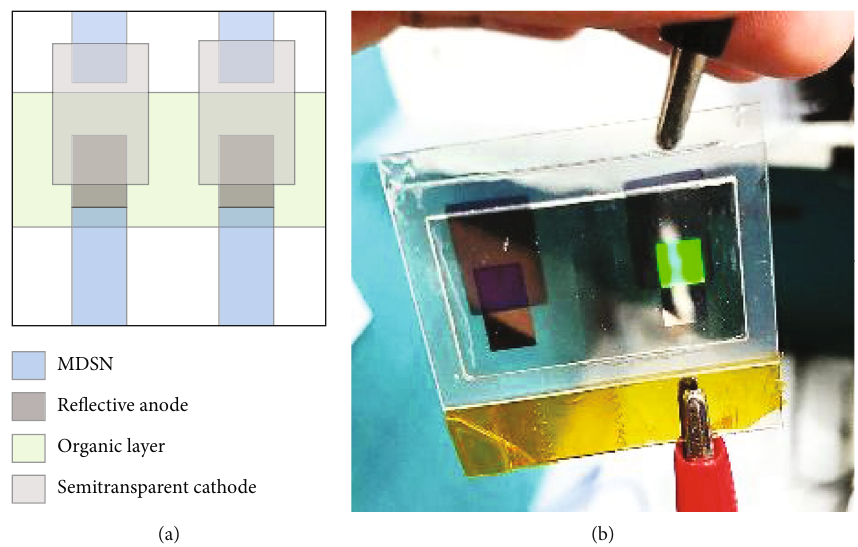
Figure 1: (a) Device patterns and (b) emission photo of TE-OLED with encapsulation.